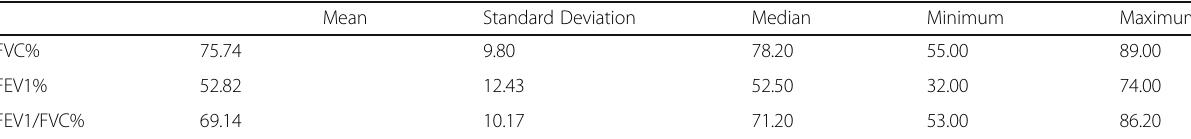
Table 5 PFT results